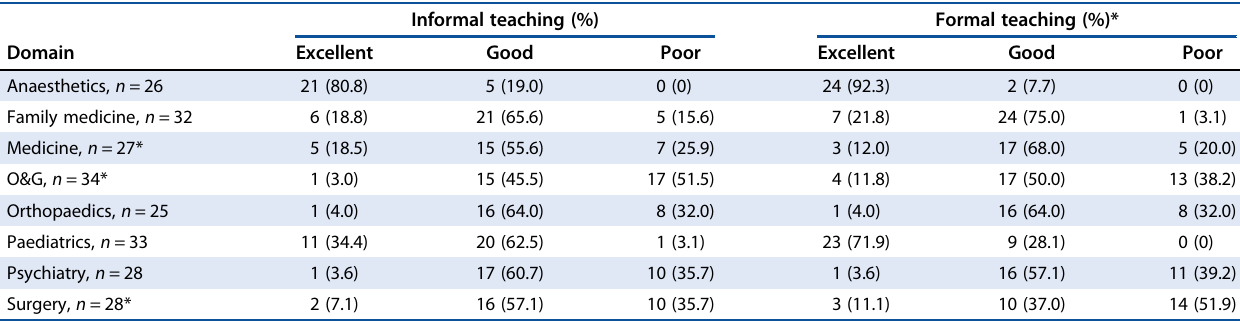
Table 2: Interns ’ perception of the quality of formal and informal teaching received at KEH